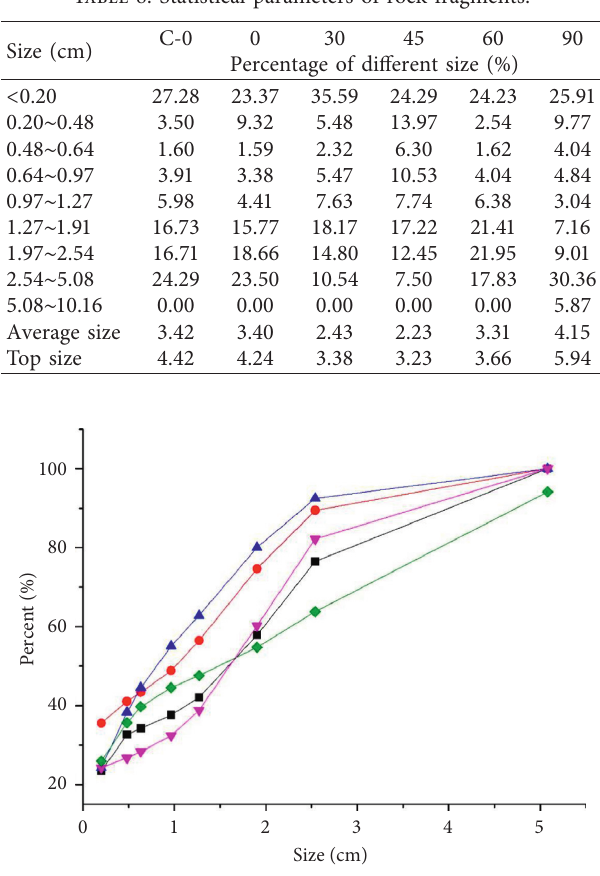
Table 8: Statistical parameters of rock fragments.